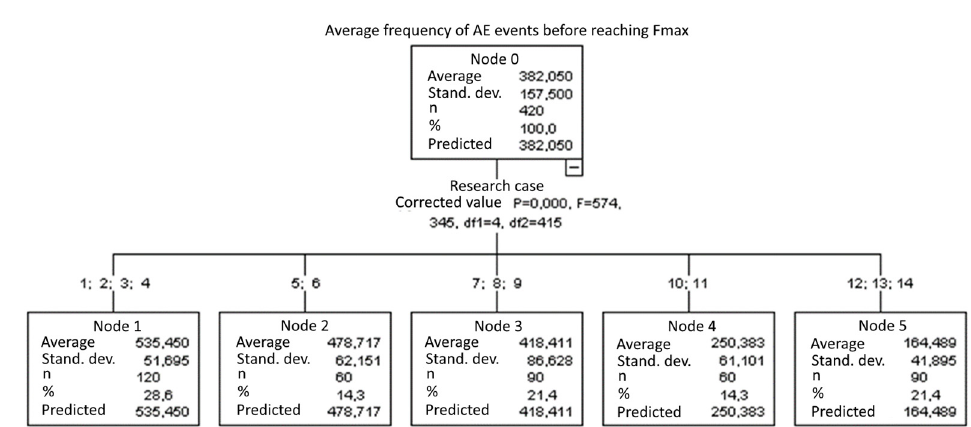
Figure 28. Classification tree for the average frequency of AE events before reaching F max .